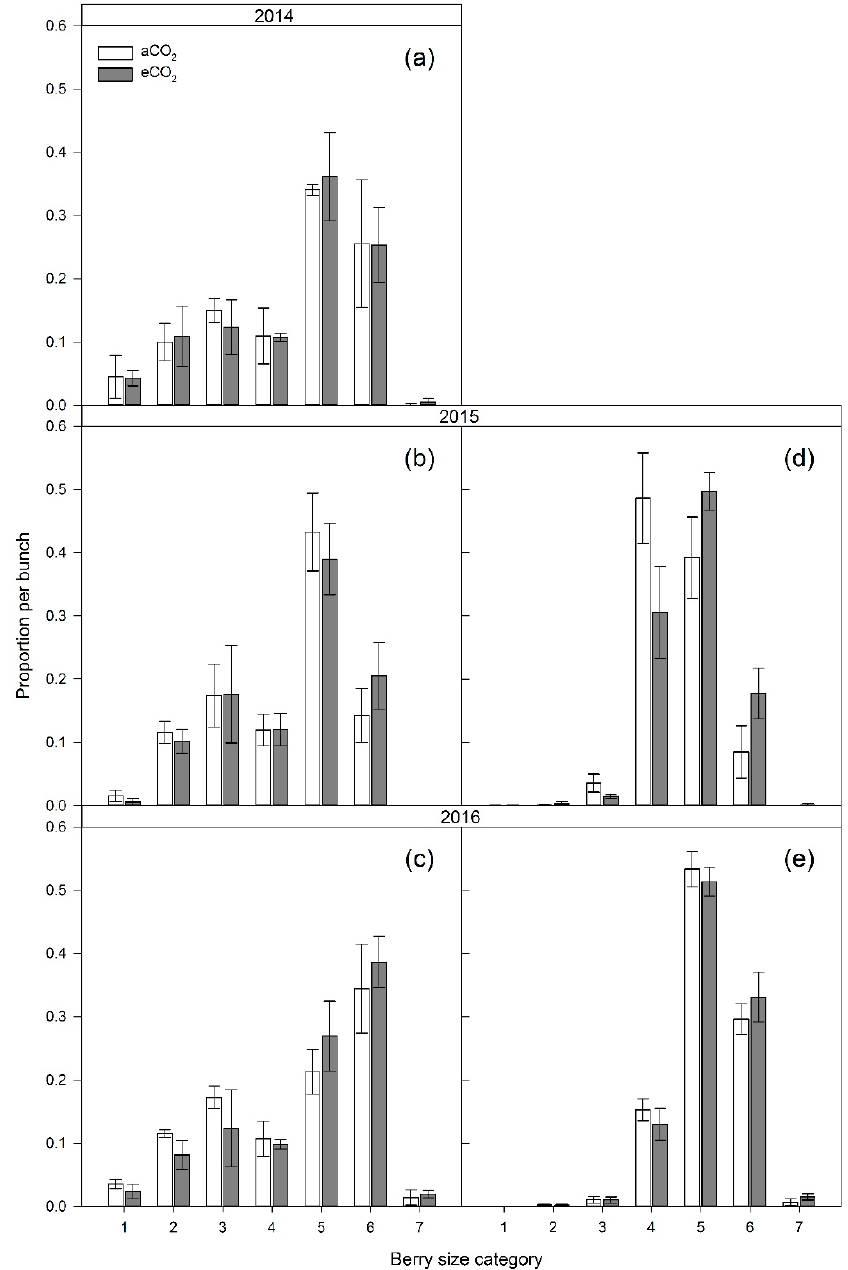
Figure 11. Proportion per bunch of Riesling berry size groups for aCO 2 and eCO 2 in 2014 ( a ), 2015 ( b ), and 2016 ( c ) and Cabernet Sauvignon in 2015 ( d ) and 2016 ( e ). Berry size categories represent the following berry size classes: 1 (<6.3 mm), 2 (6.3–8 mm), 3 (8–10 mm), 4 (10–12.5 mm), 5 (12.5–14 mm), 6 (14–16 mm), and 7 (16–18 mm). Mean values per treatment ± SD of the three FACE rings.